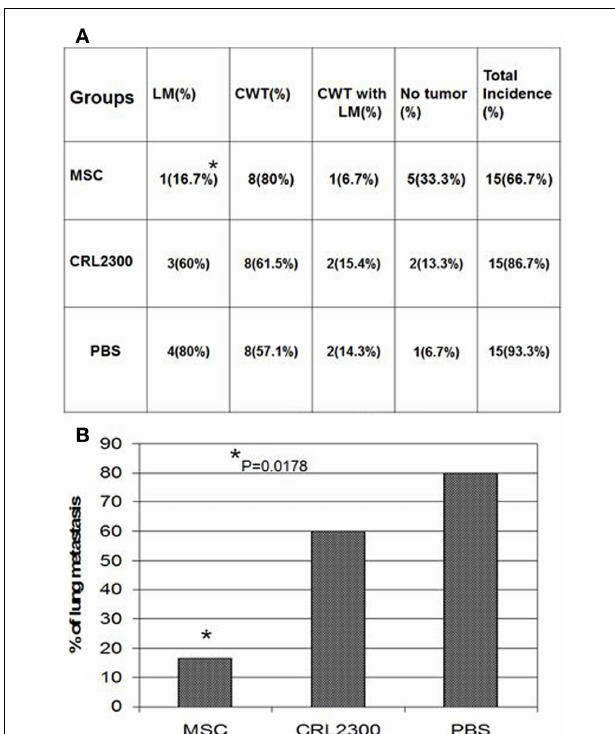
FIGURE 5 | MSC treatment significantly reduces lung metastasis in orthotopic xenograft model of Ewing’s sarcoma. MSC treated mice compared to two control groups. Lung metastases are significantly fewer. MSC, mice treated with mesenchymal stem cells weekly for 3weeks; CRL2300, lung epithelial cells, labeled the same as MSCs to serve as control; PBS, phosphate buffered saline injected group to serve as a second control group; LM, lung metastasis; CWT, chest wall tumor. Lung metastasis significantly decreased in size * p = 0.0178. (B) is a bar graph of data displayed in (A)